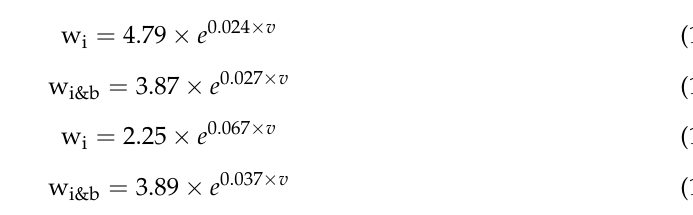
Figure 18. Relationship between water absorption and voids for RHA and RAP concrete.